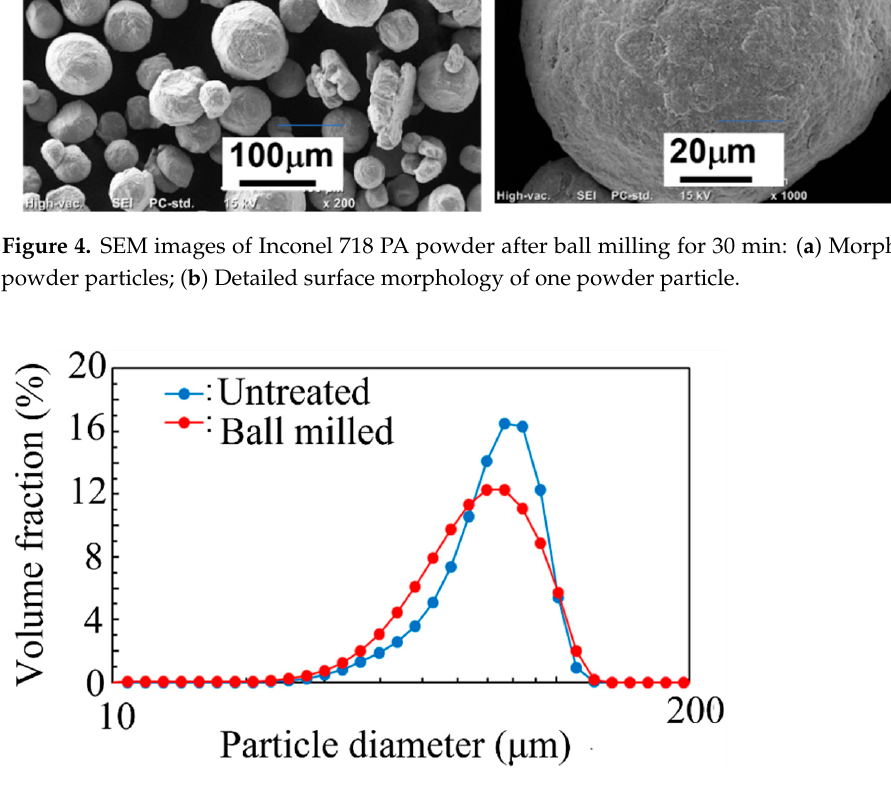
Figure 5. Particle size distribution of Inconel 718 PA powder before and after ball milling for 30 min. Table 4. Characteristic parameters related to particle size distribution of Inconel 718 PA powders before and after ball milling for 30 min in air.